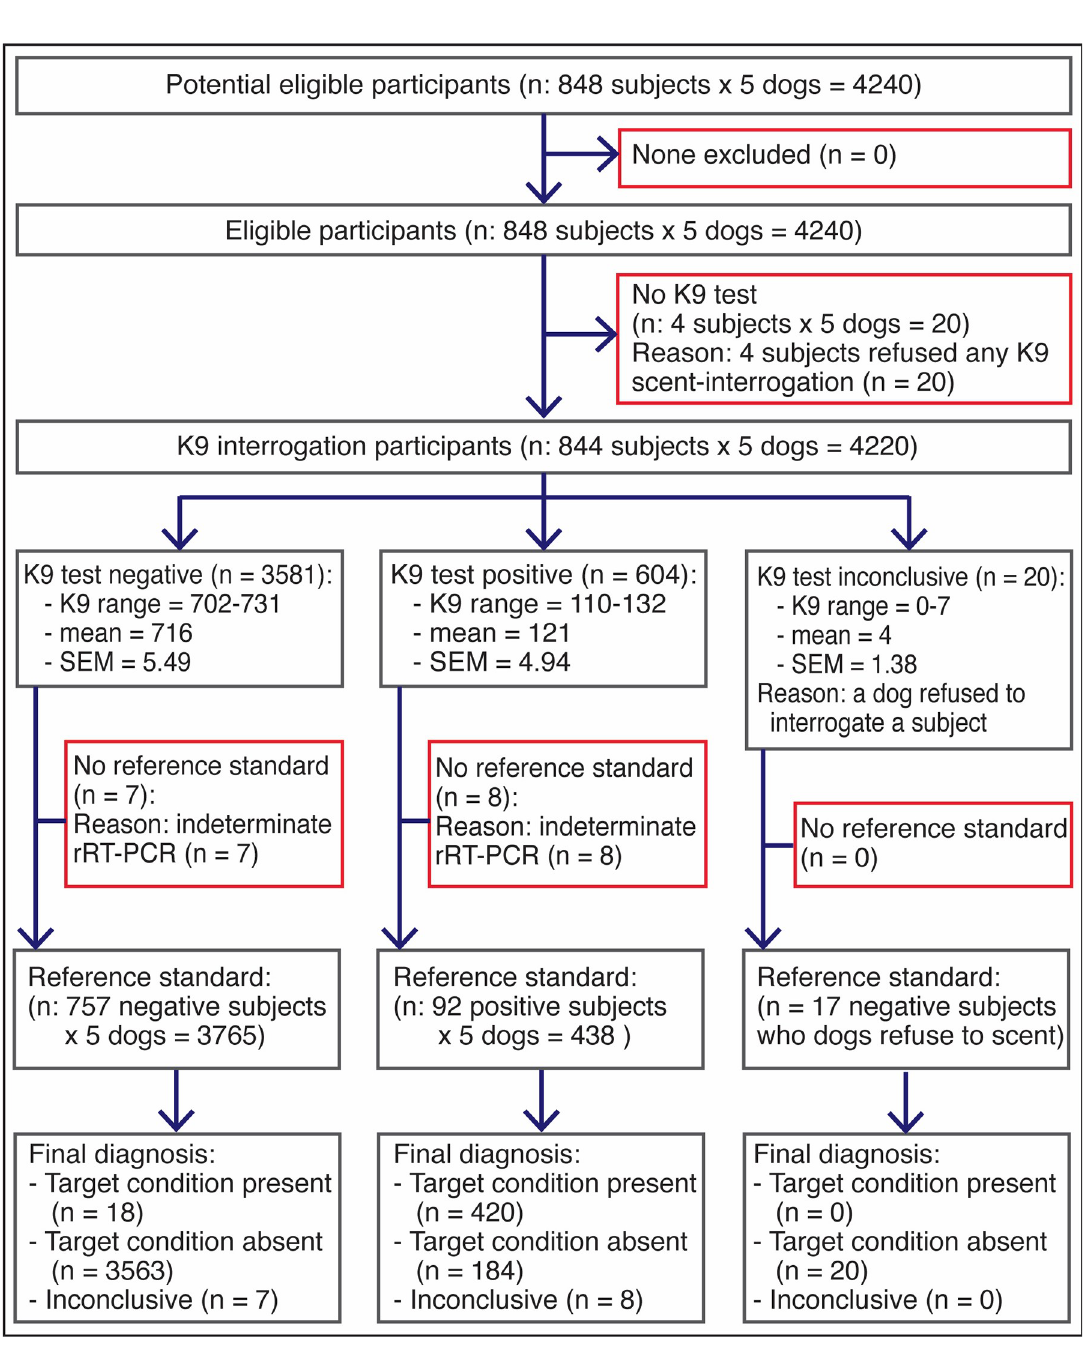
Fig 3. Phase 3: In vivo screening (efficacy trial). Diagram illustrating the flow of human participants in the third phase of the study. confirmed in 92 patients (10.8%) and 753 (88.8%) tested negative. The other 3 (0.4%) were asymptomatic subjects with “indeterminate” rRT-PCR results after repeated testing; they were excluded from the analysis (Fig 4). The average cycle threshold (C ) of the rRT-PCR positive T patients was 32.0 (range, 20.6–38.8). COVID-19 was diagnosed by antigen test (Standard Q COVID-19 Ag Test, SD Biosensor) in 51 patients that had been admitted to the ER with acute respiratory distress, fever, sinus pain, cough, anosmia, or dysgeusia. Of 753 COVID-19 negative